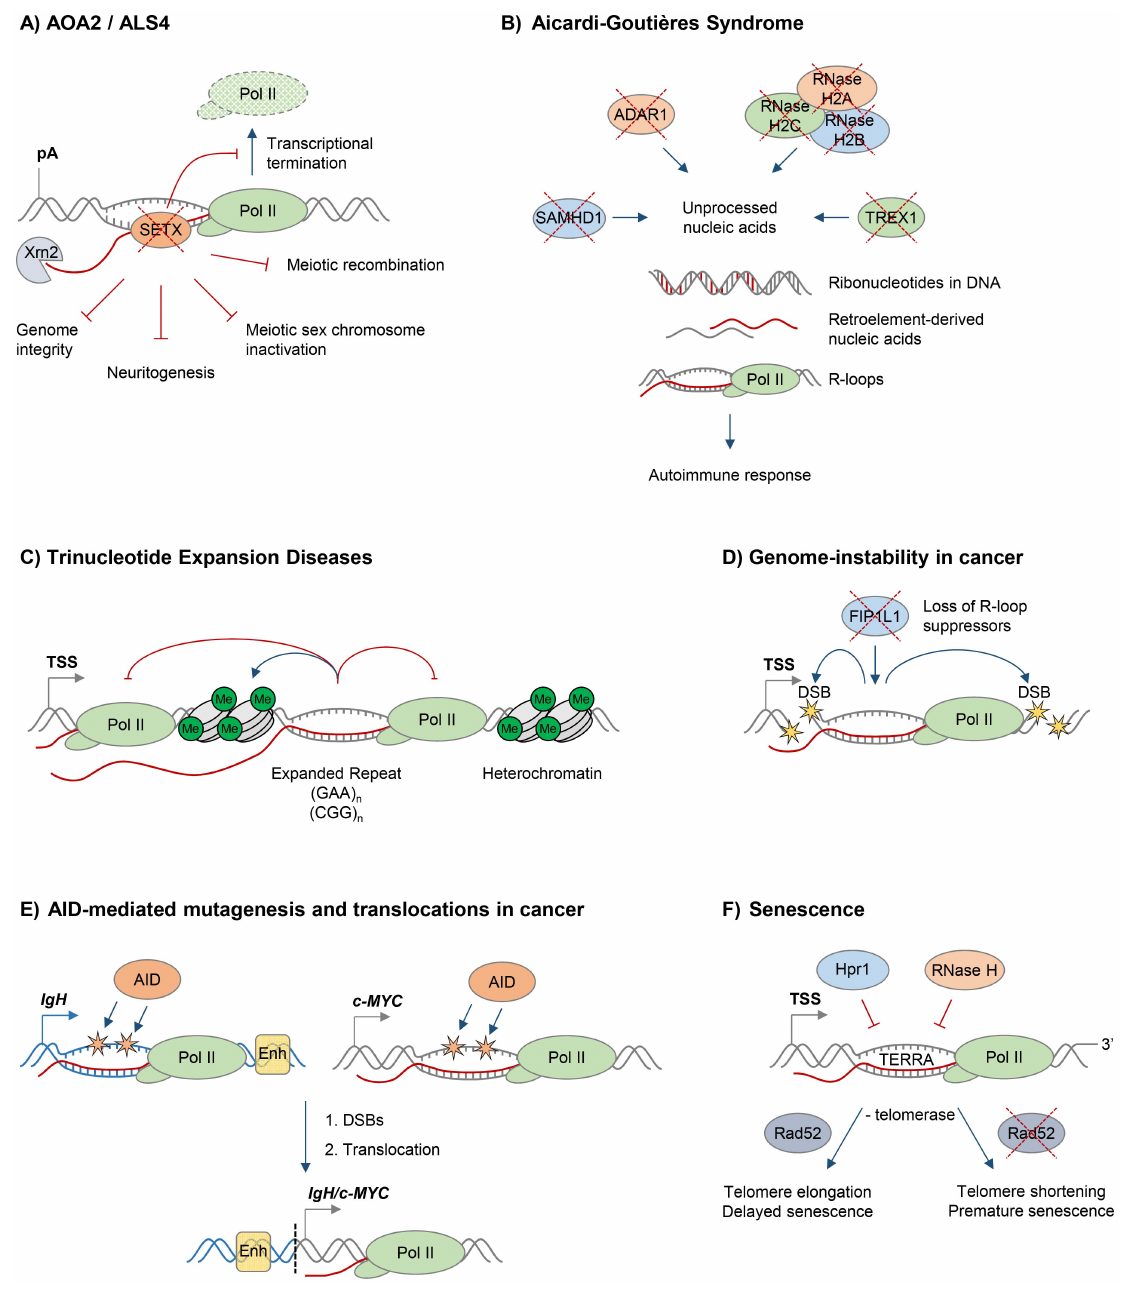
Figure 2. R-loops and human diseases. The diagram depicts the role of R-loops in human diseases. Loss of wild type protein function is depicted by red crosses. A. Ataxia and motor neuron diseases. Mutations in human RNA/DNA helicase senataxin are associated with AOA2/ALS4 disorders and lead to R-loop accumulation and defects in transcriptional termination by Pol II [16], the maintenance of genome integrity [46], meiotic recombination during spermatogenesis, gene silencing during meiotic sex chromosome inactivation [14], and neuronal differentiation [49]. B. Aicardi-Goutie`res syndrome (AGS). AGS is associated with mutations in all three subunits of RNase H2, ssDNA 3 9 –5 9 exonuclease TREX1 (DNASEIII), dsRNA-editing enzyme ADAR1, and dNTP triphosphatase SAMHD1; these trigger accumulation of unprocessed nucleic acids, including genomic DNA with incorporated ribonucleotides, R-loops, and retroelement-derived nucleic acids, and result in the immune response characteristic of AGS [65]. C. Trinucleotide expansion diseases. R-loops form over expanded repeats and result in decreased initiation and elongation of RNA Pol II and formation of repressive chromatin marks, which silence the host gene containing expanded repeats [75]. D. Genome instability in cancer. Loss of proteins protecting against abnormal R-loop accumulation, such as FIP1L1, leads to genome instability, one hallmark of cancer [31]. Yellow stars denote double-stranded DNA breaks. E. AID-mediated mutagenesis and translocations in cancer. Single-stranded DNA in R-loops is a substrate for cytidine deamination by activation-induced cytidine deaminase, leading to mutagenesis as indicated by orange stars [21,88]. These mutations can cause DSB formation, leading to chromosomal translocations. The IgH/c-MYC translocation brings the strong IgH enhancers, shown as yellow box, close to c-MYC , leading to its overexpression in Burkitt’s lymphoma [87]. Transcription of IgH/c-MYC starts from a previously inactive promoter downstream of the translocation break point. The IgH locus is depicted in blue, c-MYC gene is in grey. The translocation breakpoint is indicated by a dashed black line. F. Senescence. R-loops formed by the noncoding RNA TERRA accumulate at telomeres in cells deficient of Hpr1 and RNase H. In the absence of telomerase, these R-loops promote Rad52-dependent telomere elongation and delayed senescence. In the absence of telomerase and Rad52, R-loops promote telomere shortening and premature senescence [94].